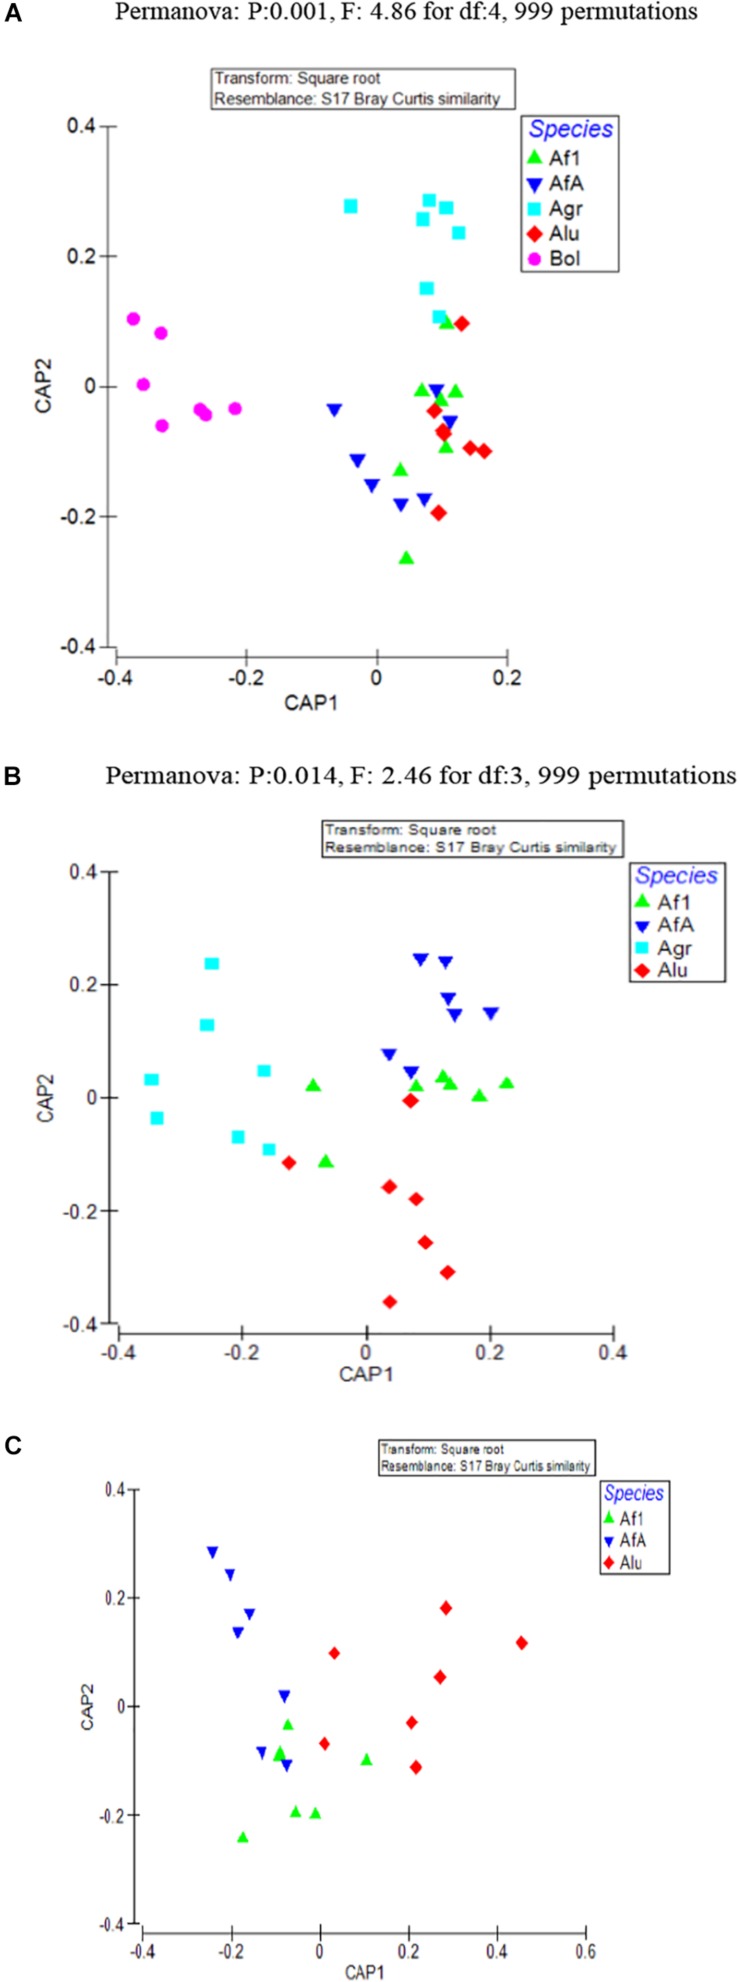
CAP was used to find axes that best discriminate the groups of interest. In this analysis, clustering at insect species level was examined. (A) All samples representing the five laboratory populations are included (B) Only the four Anastrepha laboratory populations (Anastrepha grandis, Anastrepha ludens, and Anastrepha fraterculus) are included. (C) Only the three laboratory populations from the A. fraterculus intergeneric group (A. ludens and A. fraterculus) are included. Af1, A. fraterculus sp. 1; AfA, A. fraterculus (Andean lineage); Agr, A. grandis; Alu, A. ludens; Bol, B. oleae.